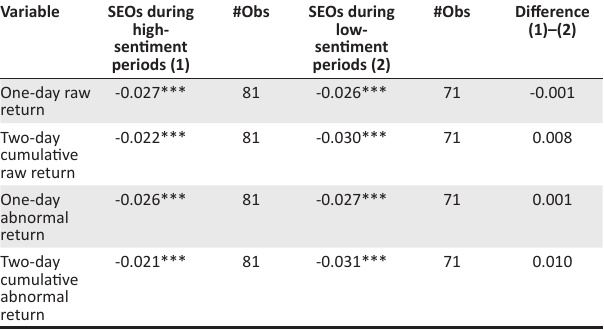
FIGURE 2: Secondary equity offering announcements across the sample period. TABLE 6: Investor sentiment and the stock market’s reaction to secondary equity offering